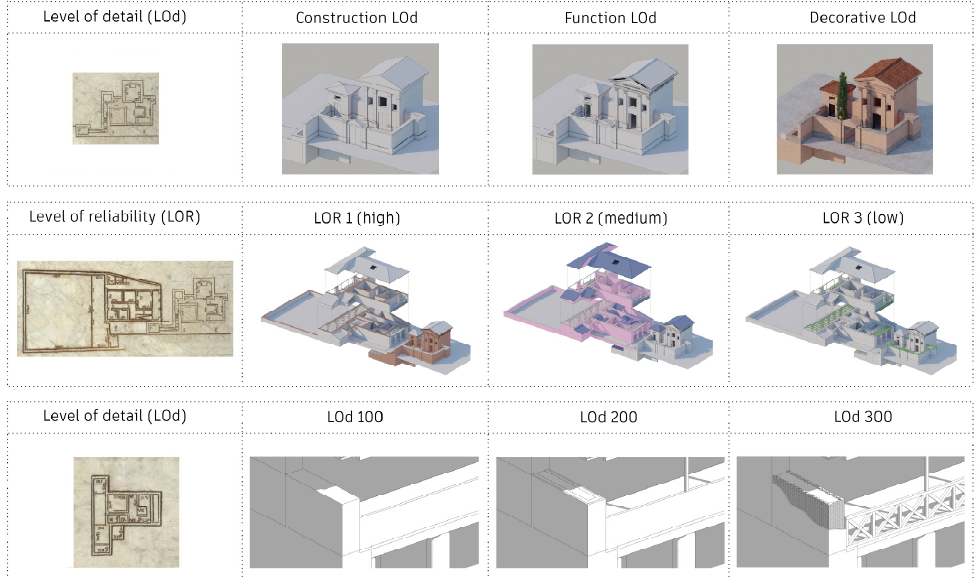
Figure 7. The differentiation in LoD referring to the functionality, the graphical and geometrical details in the models and the distinction of three different Level of Reliability referring to the process used to reconstruct the final model: high reliability refers to the reconstruction of the plan based on the engravings and the mathematical calculation, medium refers to the vertical structures reconstructed on bibliographical data, low consists on the accessories elements as parapets, for which no data where found.